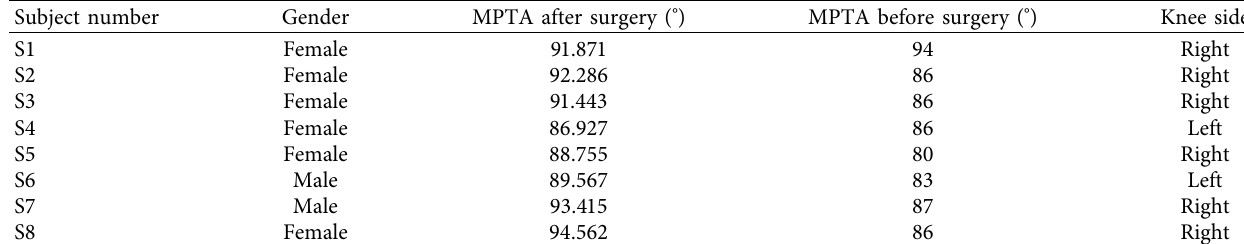
Table 2: MPTAs of subjects’ knees after the